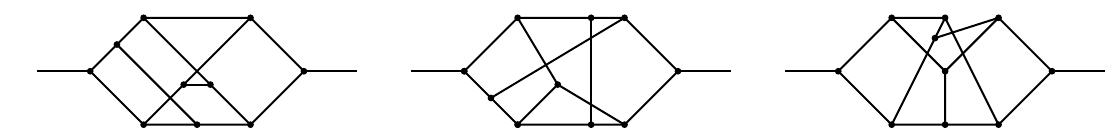
Figure 4 . The integral families for which bad denominators survive the change of basis. The diagram on the left shows family P 46